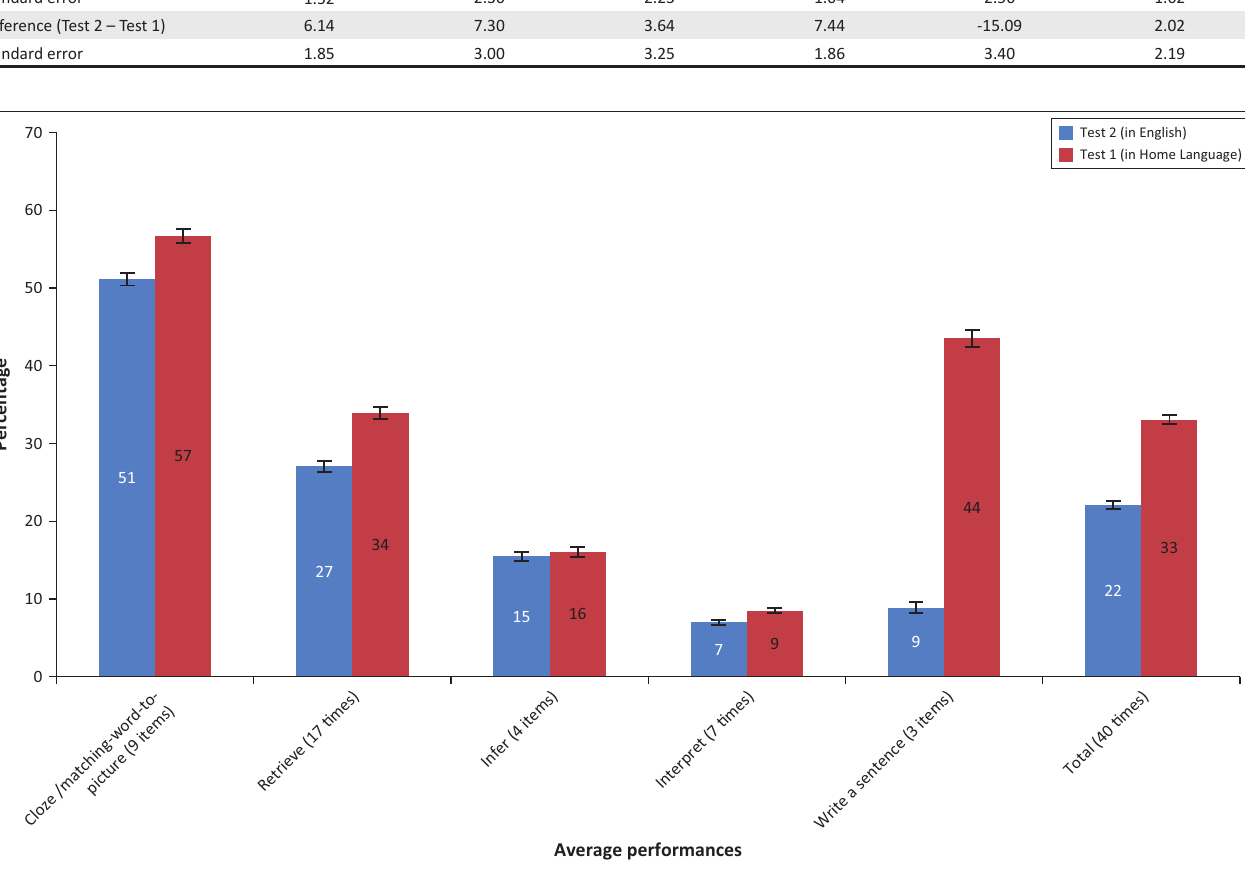
FIGURE 2: Average performance ( % ) in Test 1 (Systemic Evaluation) and Test 2 (National School Effectiveness Study) by literacy process for students whose home language is not English ( n =